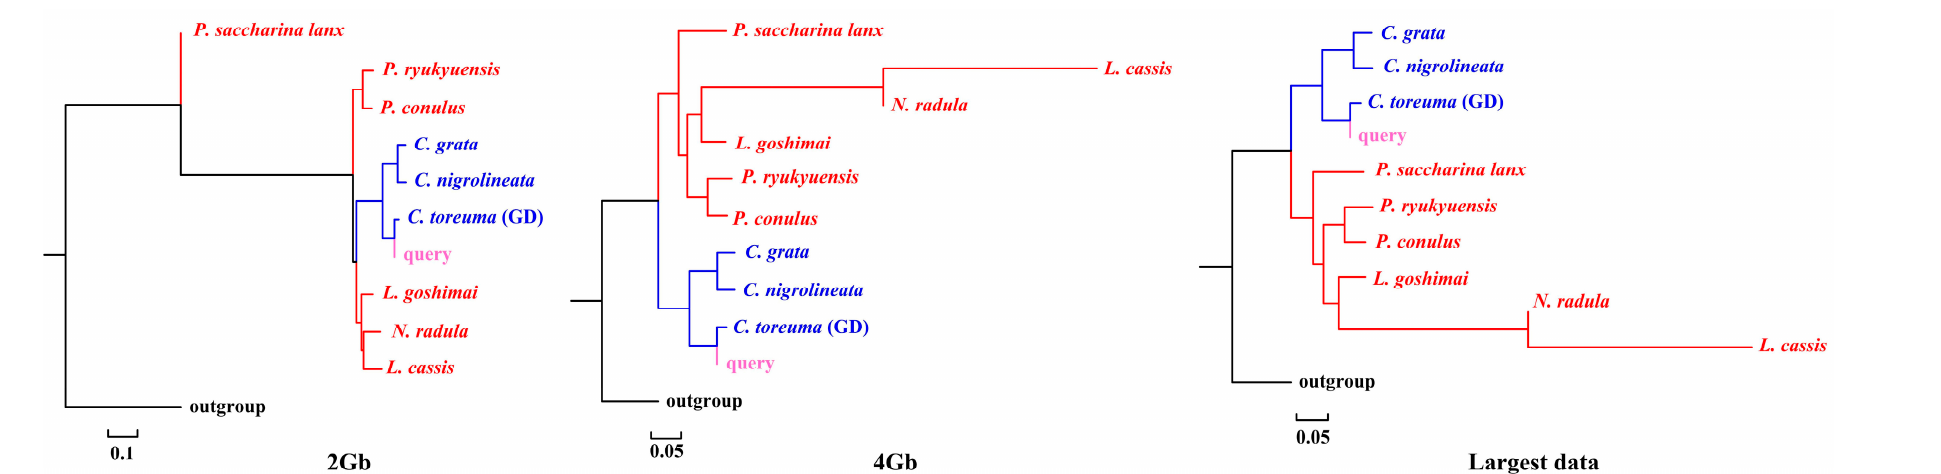
Figure 2. Phylogenetic placement of C. toreuma (query species) under different sizes of genome skims.